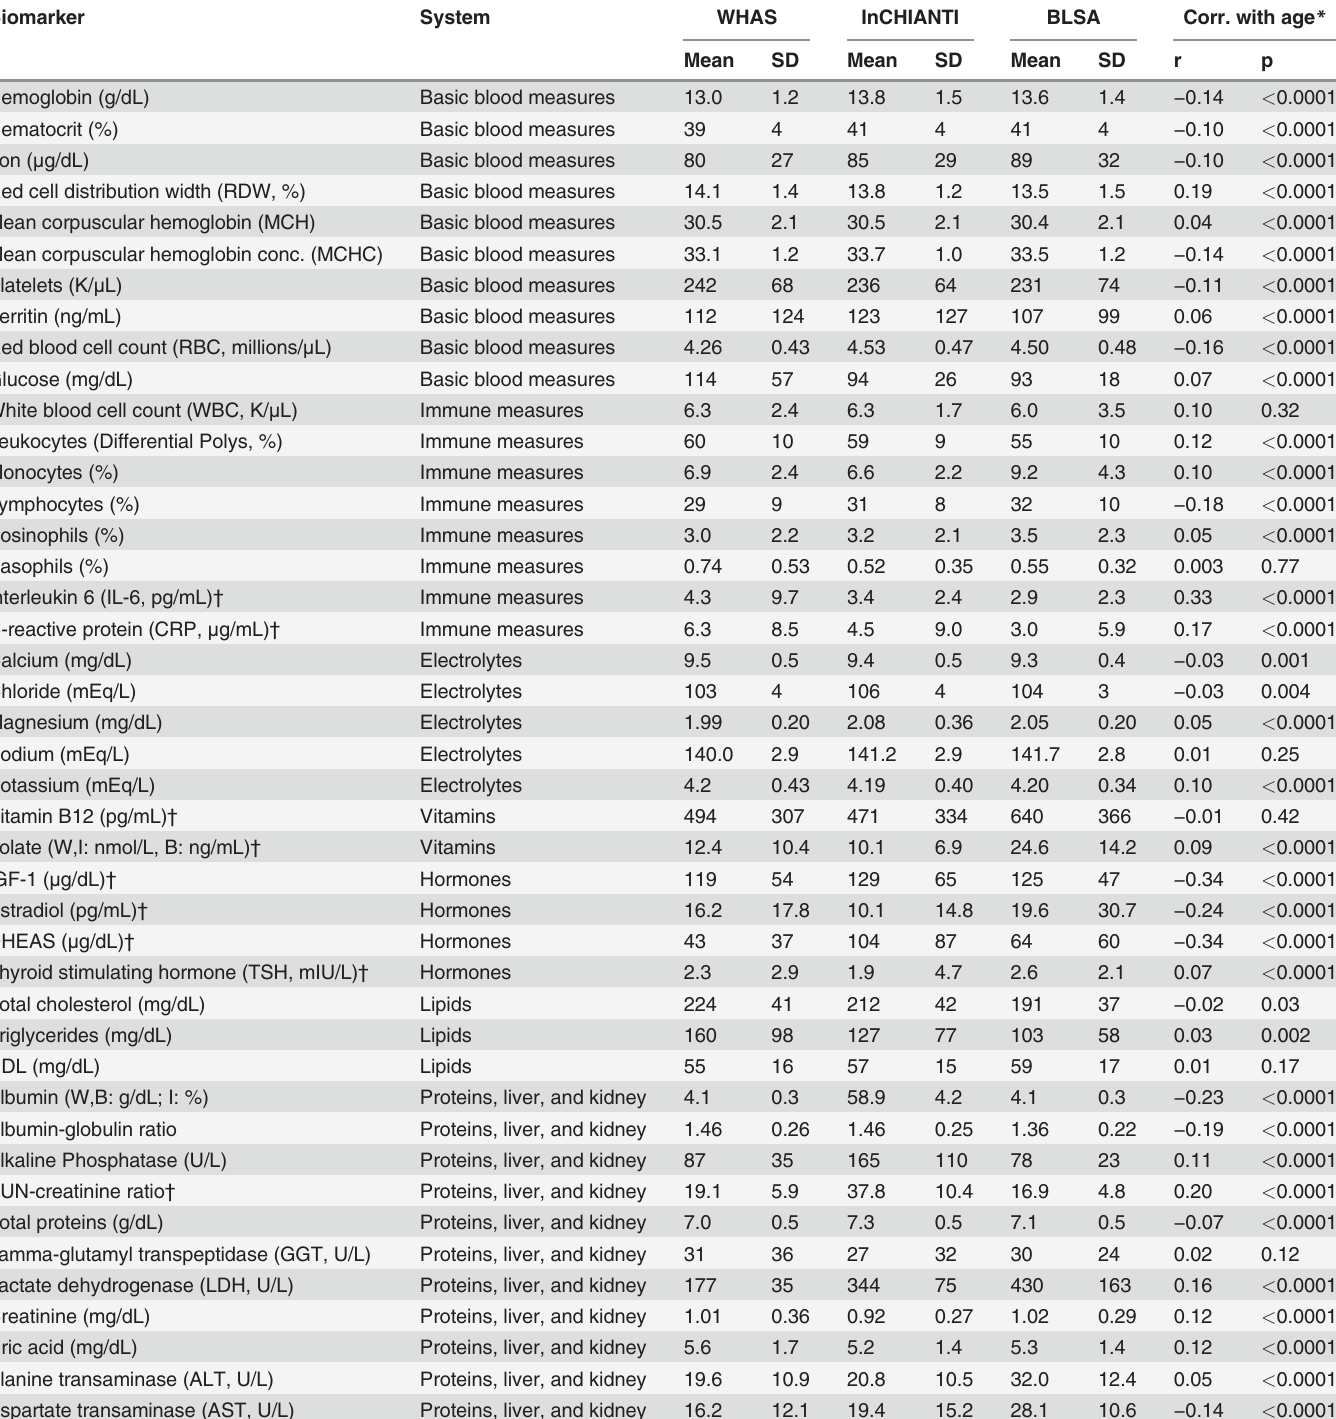
Table 1. Biomarkers used, their values by data set, and correlations with